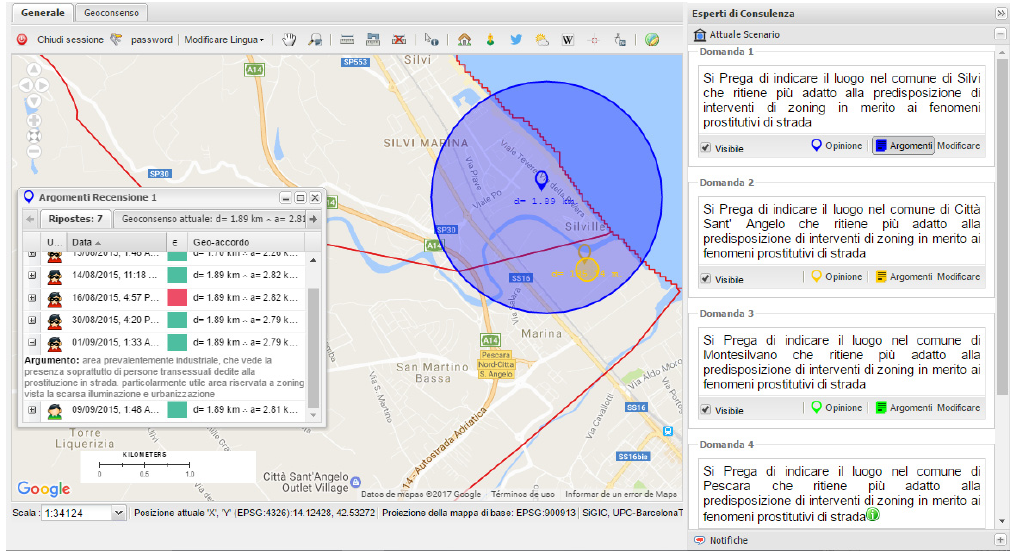
Figure 7. Specific case concerning the potential intersection of the locations corresponding to questions 1 and 2 for the municipalities of Silvi and Città Sant’ Angelo.